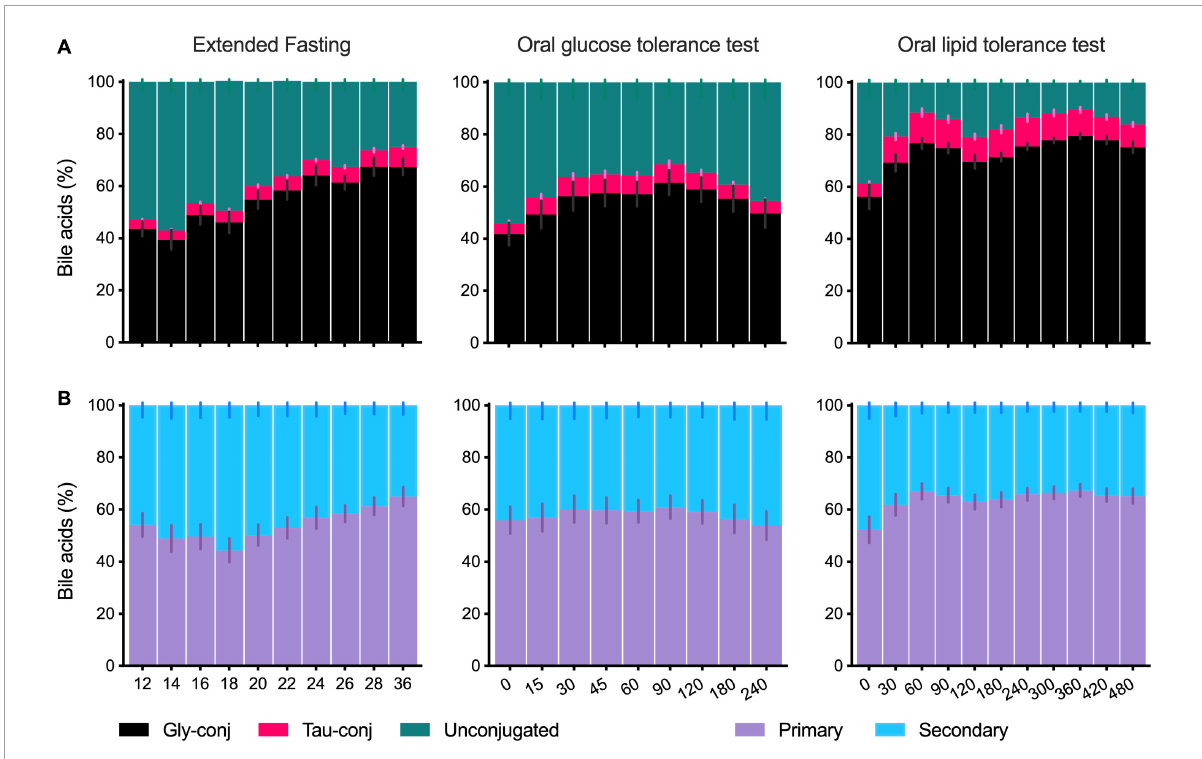
FIGURE3 Composition of the plasma bile acid profile in the postprandial state and during the extended fasting. (A) Percentage of the sums of unconjugated, glycine- and taurine-conjugated BA in the total profile as collected during the extended fasting, OGTT and OLTT. (B) Percentage of the sums of primary and secondary BA in the plasma BA profile collected during the extended fasting, OGTT and OLTT. Data presented as mean ± SEM ( N = 15). The X -axis for fasting is given in hours and the X -axis for OGTT and OLTT is in